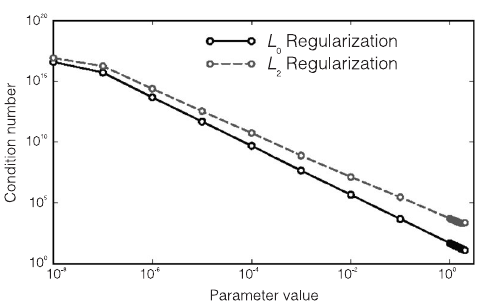
Fig. 5. Effect of matrix regularization on the condition number: high values of a lower the condition number.